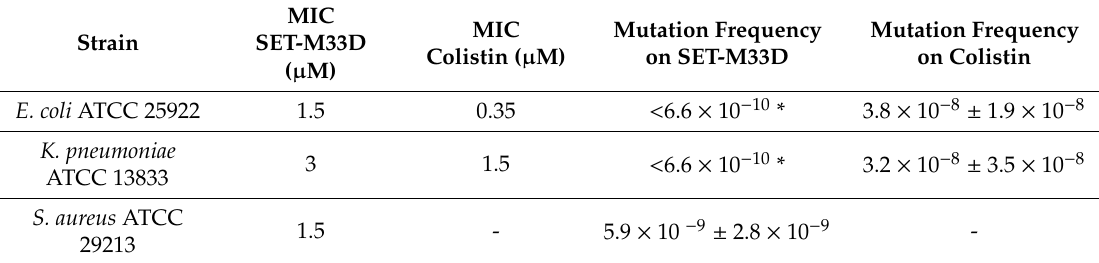
Table 2. Frequency of selection (mean ± SD) of resistant mutants on three reference strains after exposure to SET-M33D and to